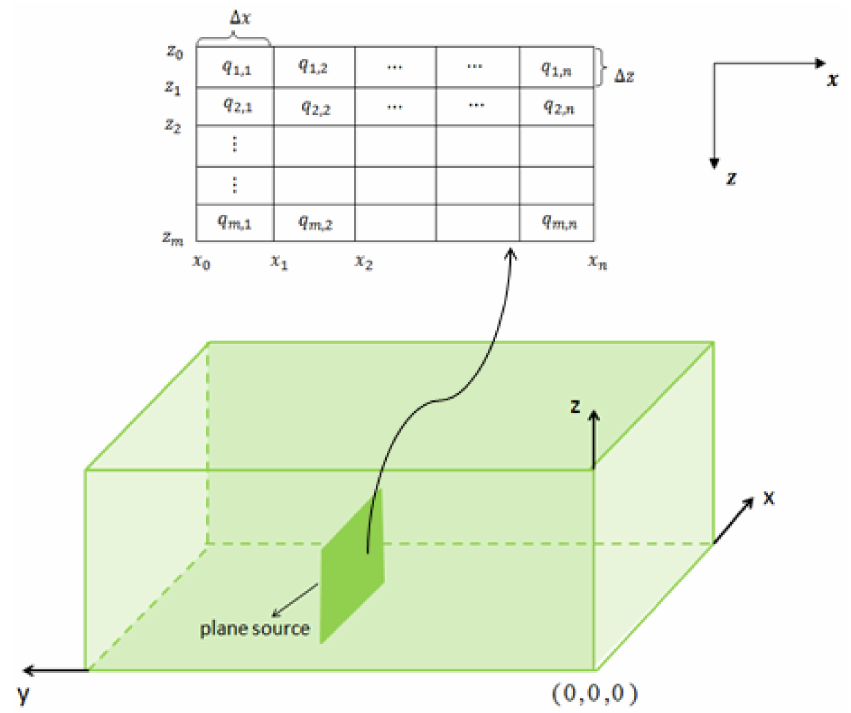
Figure A2. Division of a plane